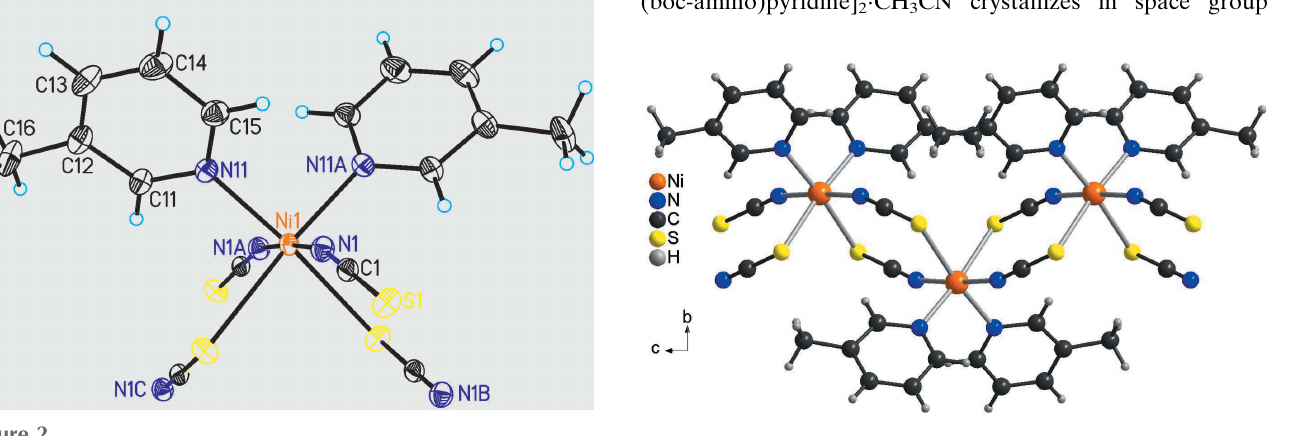
Figure 3 Crystal structure of the title compound with view of part of a chain showing the Ni coordination along the crystallographic a . 2